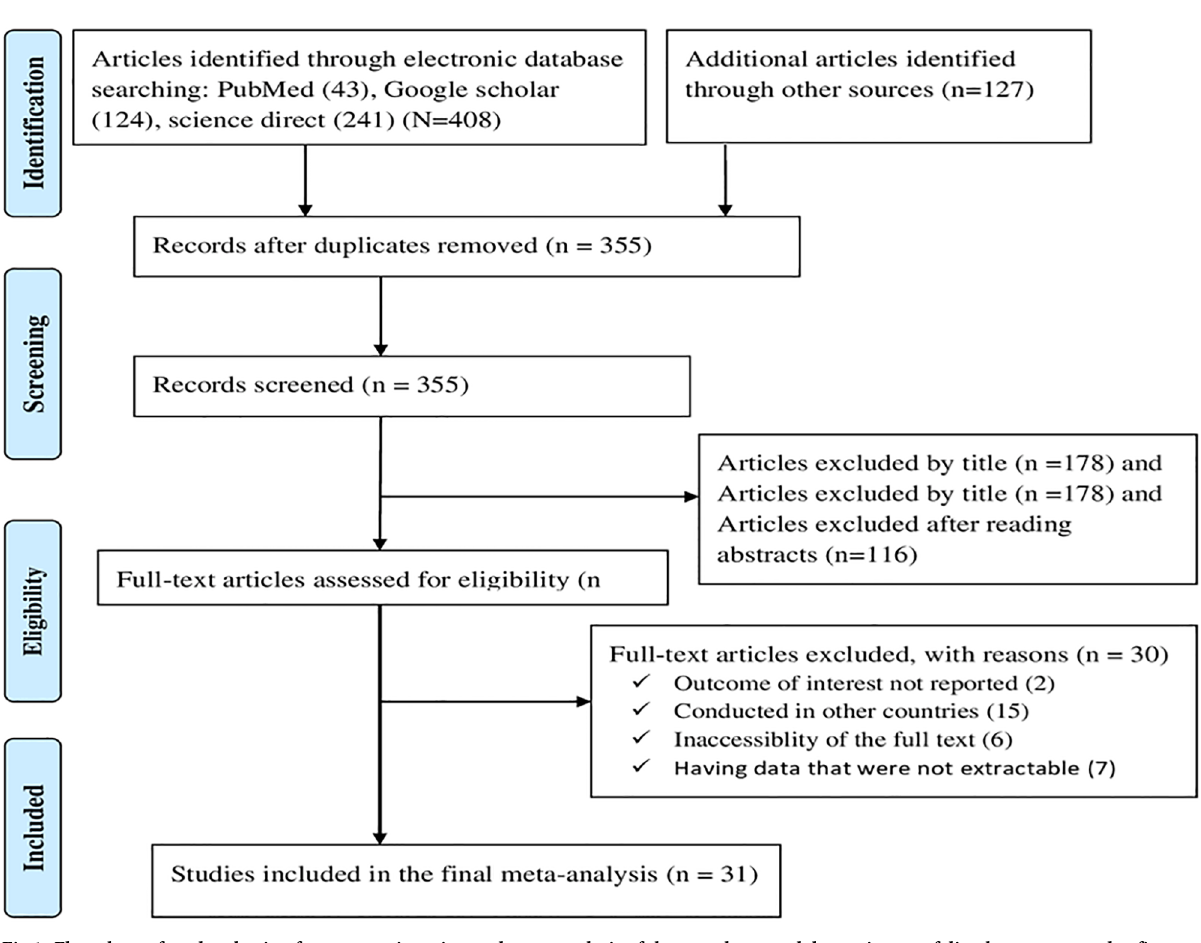
Fig 1. Flow chart of study selection for systematic review and meta-analysis of the prevalence and determinants of diarrhea among under-five children in Ethiopia.